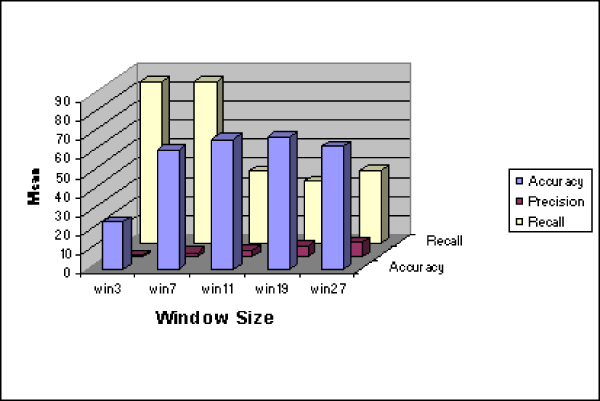
Six-fold cross-validation results for Improved DomainDiscovery (in average). Six-fold cross-validation results for Improved DomainDiscovery; determined by using SVM classifiers for the Benchmark_2 dataset.